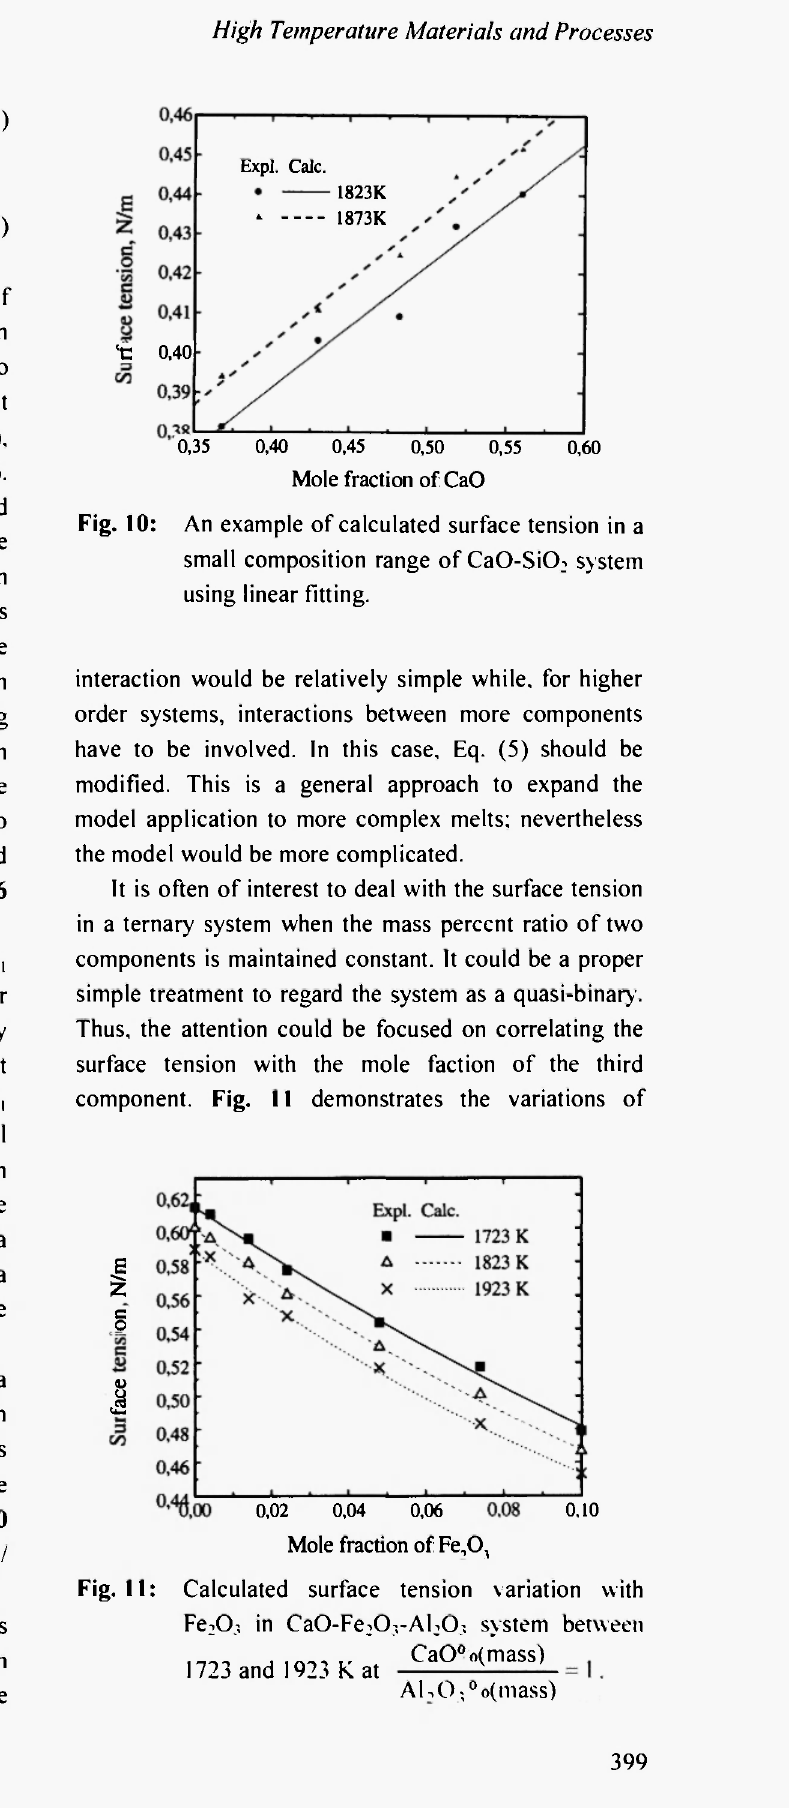
Calculated surface tension variation with Fe 2 0 3 in Ca0-Fe 2 0 3 -Al 2 0 3 system between CaO°o(mass) 1723 and 1923 Κ at Al,0,°o(mass)